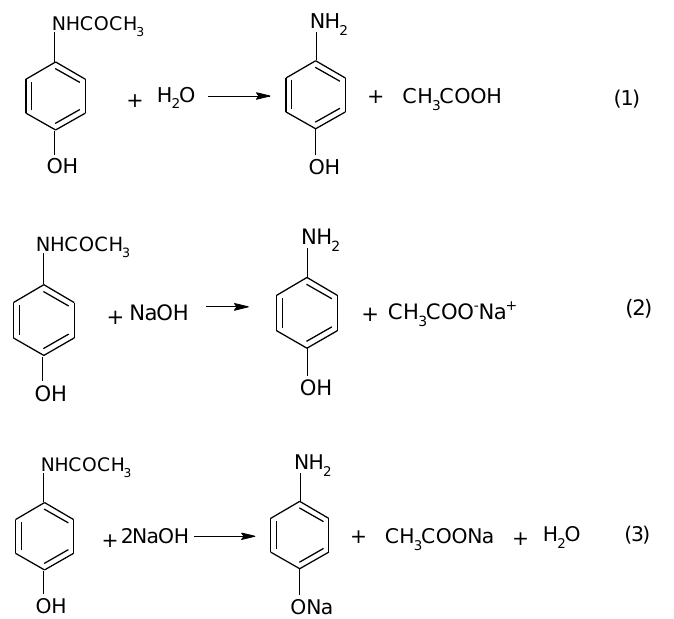
Scheme 1. The chemical reactions of AC with H 2 O (Equation ( 1 )) and NaOH (Equation ( 2 )). The interaction of AC with an excess of NaOH is described by Equation ( 3 ).